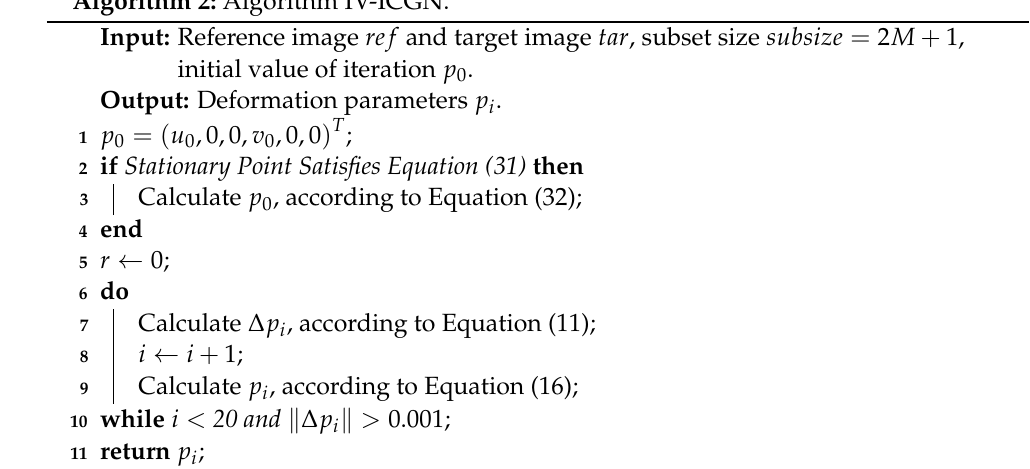
Algorithm 2: Algorithm